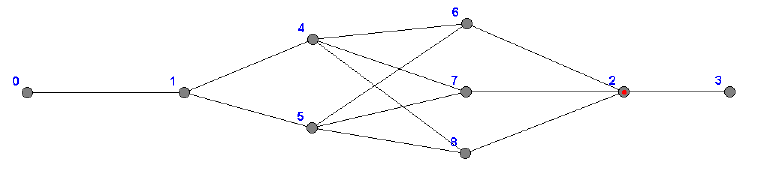
Figure 1. Graph of exp ( P 5 ,1,1,2,3,1,1 ) .